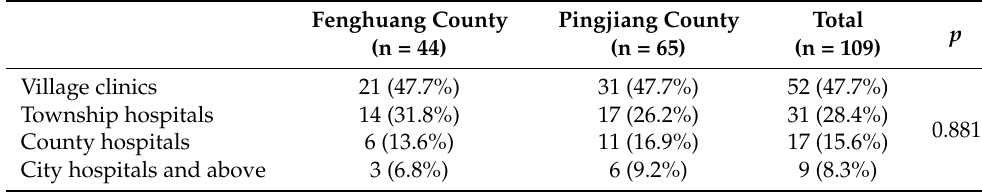
Table 3. Visits in the hospitals at different levels (n,